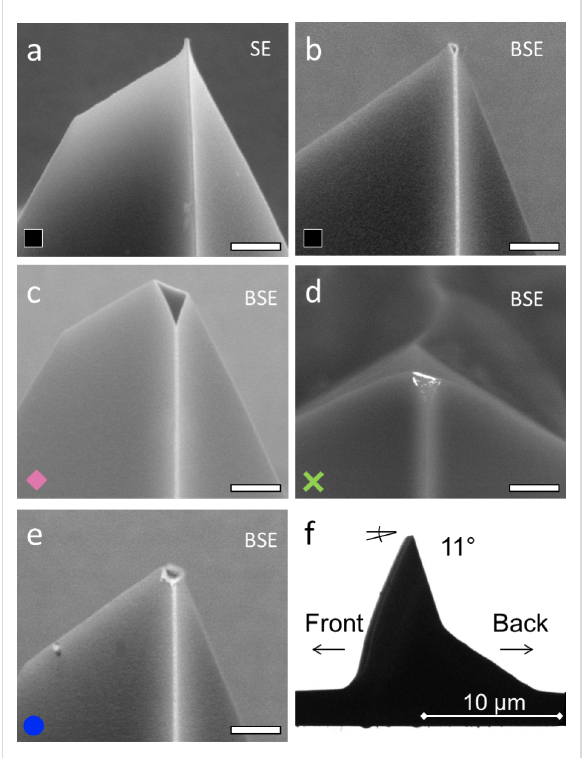
Figure 6: Scanning electron microscopy (SEM) images (secondary electrons (SE), back-scattered electrons (BSE)) of tip apices used in the experiments. The scale bars in panels a) to e) correspond to 500 nm. a) Au/Si tip after sliding for a distance of 4.8 mm on oxidized Si(100), with no detectable wear. b) Au/Si tip after activation and sliding for a distance of 20 mm on oxidized Si(100); the tip was worn by 325 nm. c) Au/Si tip after sliding for a distance of 10 mm on reac- tive Si(100); the height difference to the intact tip was about 530 nm. d) SiO x /Si tip after sliding for a distance of 17.7 mm on reactive Si(100) and Au(111); the tip was worn by 880 nm and Au was transferred from the surface to the tip apex (white contrast). e) Au/Si tip after activation and sliding for a distance of 260 mm on Au(111); tip wear was 370 nm. f) TEM side view of a non-coated AFM tip after sliding. The angle of the worn tip apex corresponds to the angle between cantilever holder and surface of